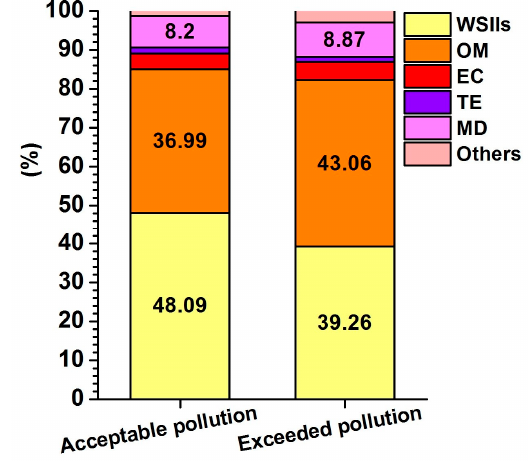
Figure 4. Average composition percentages of PM 10 during the period of acceptable and exceeded pollution. Explanations: Water soluble inorganic ions (WSIIs), organic matter (OM), elemental carbon (EC), trace elements (TE), mineral dust (MD).